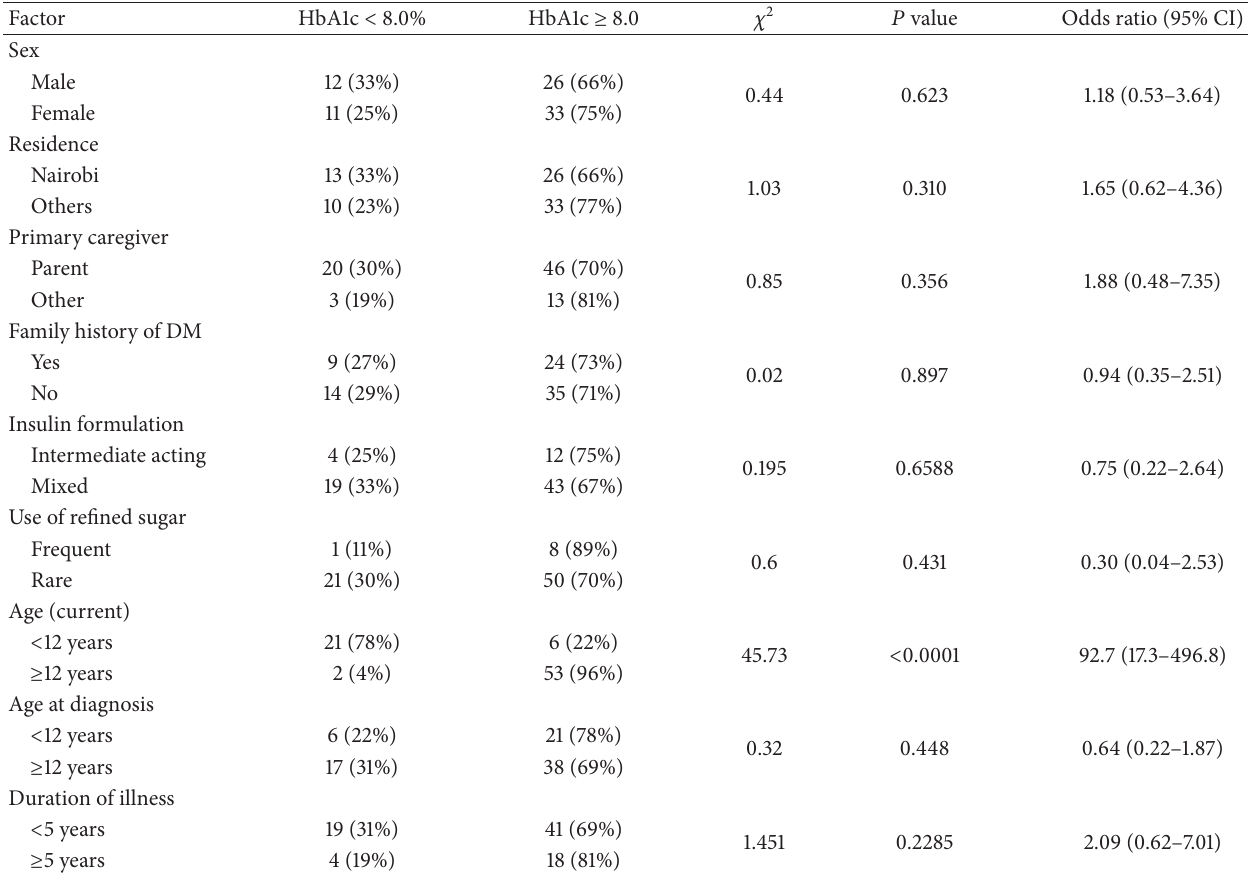
Table 1: Sociodemographic factors and glycemic control.